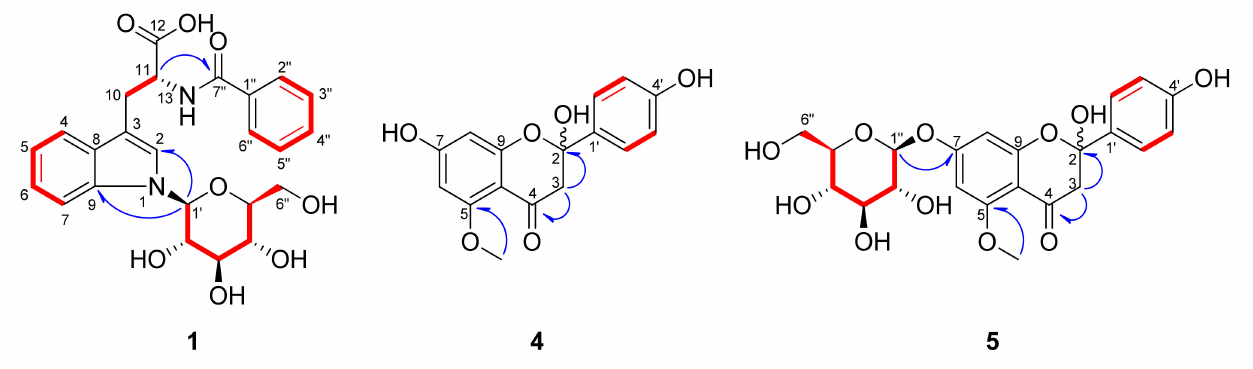
Figure 2. Key 1 H- 1 H COSY ( ) and 1 H- 13 C HMBC ( ) correlations for the new compounds 1 , 4 , and 5